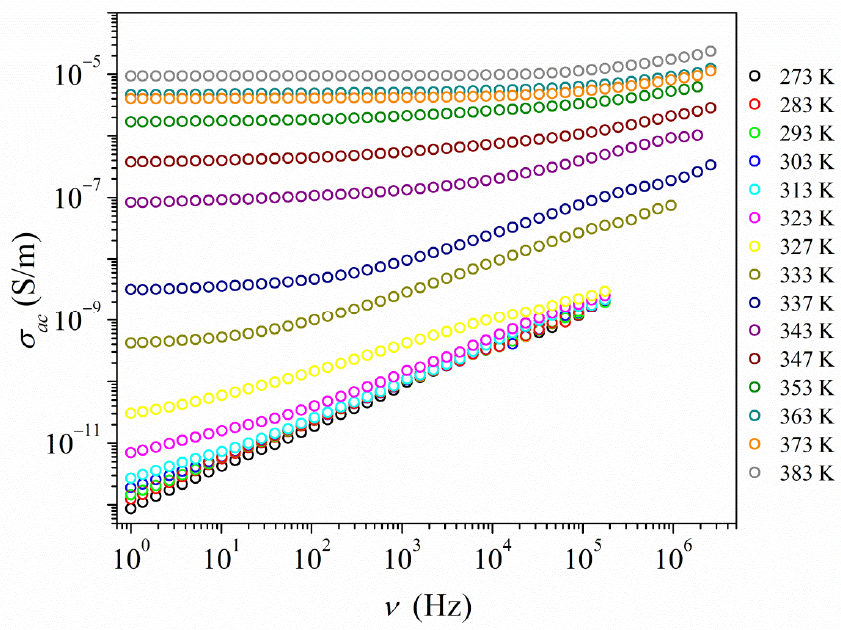
Figure 7. Dependence of the real part of electric conductivity as a function of frequency and temperature obtained for PyrHem×H 2 O.